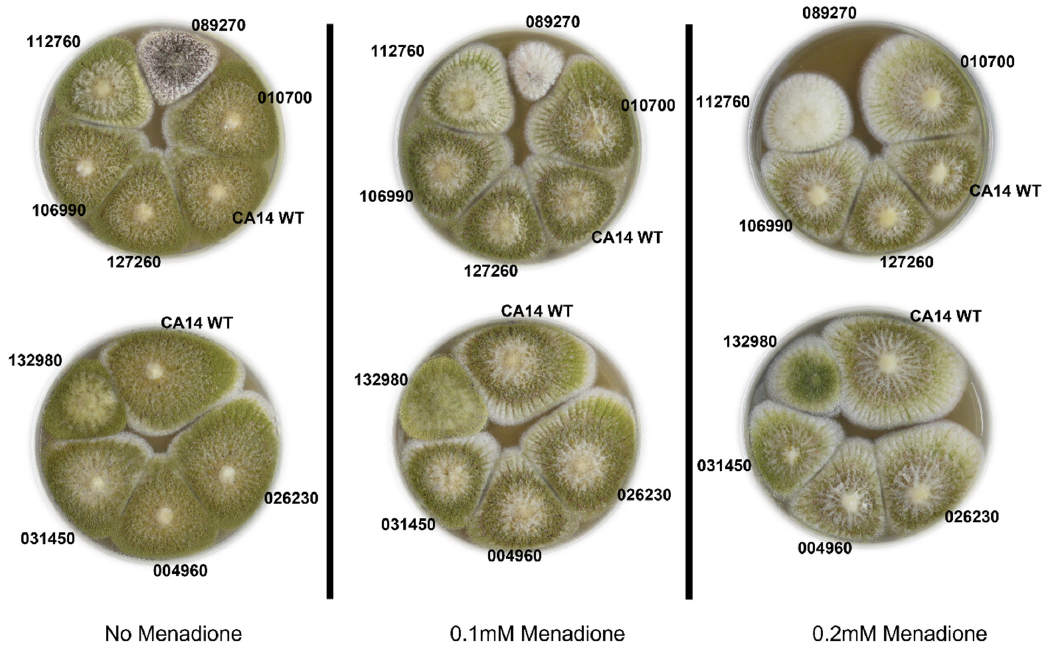
Figure 5. Menadione exposure to A. flavus transcription factor knockout strains indicates low toler- ance to oxidative stress in two strains, transcription factor knockout AFLA_089270 and AFLA_112760. The two plates vertical to each other contain all the strains tested, with increased menadione concentration from left to right. tration from left to